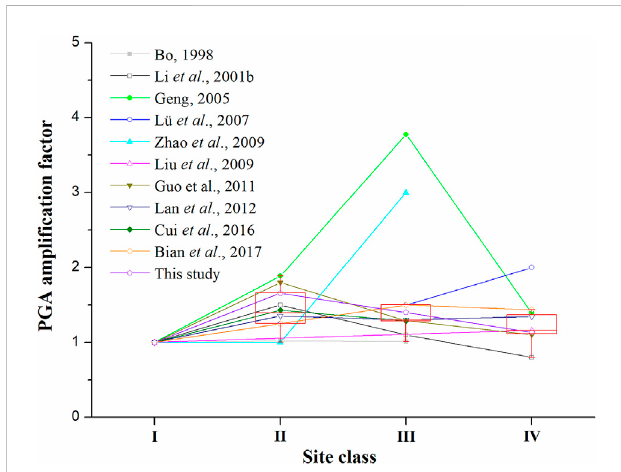
FIGURE 2 PGA ampli fi cation factors and their box-plots on site class II, III, and